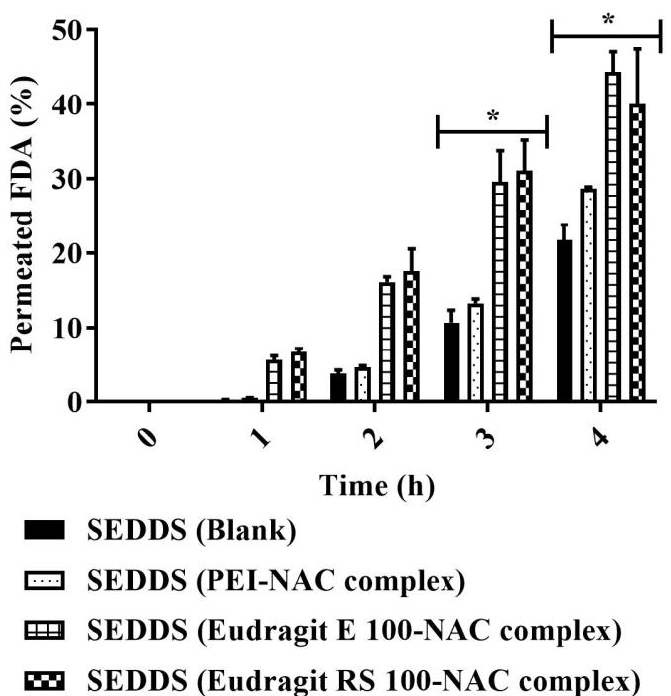
Figure 10. Transwell diffusion model assessing the amount of the diffused SEDDSs as a function of SEDDS FDA load that permeated the mucus gel layer over 4 h at 37 °C. By measuring FDA permeated percentage, the mucodiffusion comparison was drawn between the blank and mucoactive (loading different NAC polymer ionic complexes) SEDDSs. At 3 and 4 h, mucoactive SEDDSs had a significantly larger proportion of permeated FDA than blank SEDDSs (* p ≤ 0.05). Indicated values are the means ± standard deviations ( n ≥ 3).